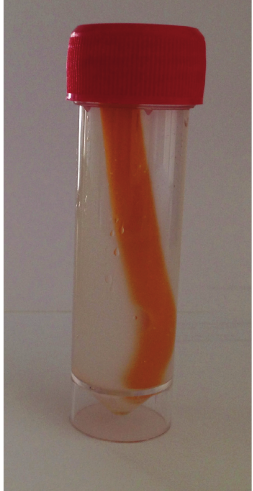
Figure 2: The incubation period of each catheter segment into a 50 mL Falcon tube. 45 mL is the total volume of the solution in each